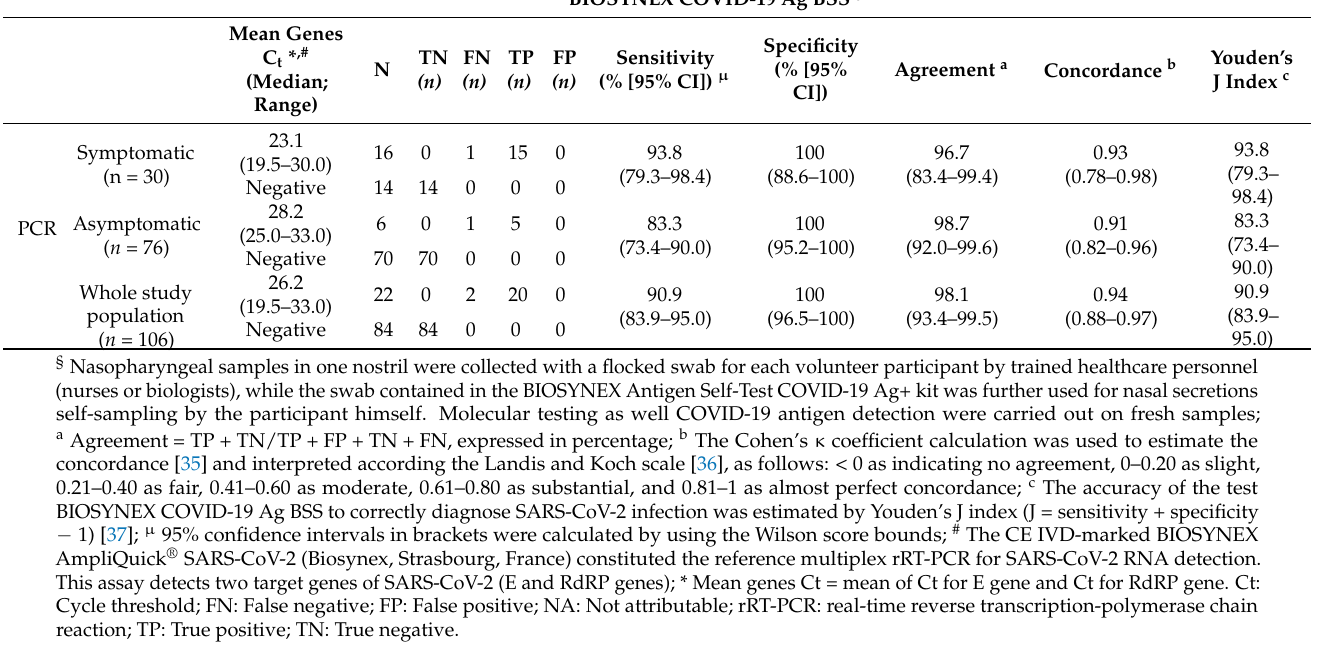
Table 5. Analytical performance of the BIOSYNEX Antigen Self-Test COVID-19 Ag+ for the qualitative detection of the N protein of SARS-CoV-2 using 106 prospectively collected nasopharyngeal swab samples by reference rRT-PCR#. BIOSYNEX COVID-19 Ag BSS